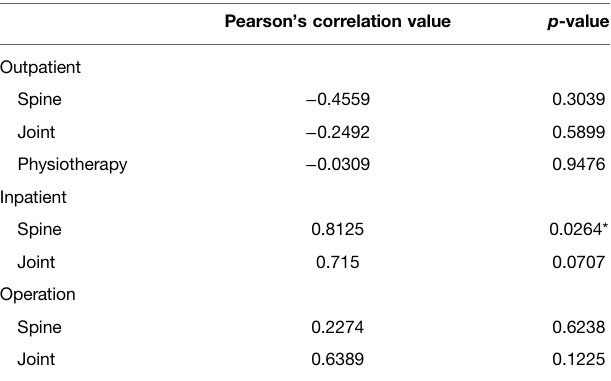
TABLE 4 | Linear relationship between the vaccination rate and visits to the orthopedic clinic. Pearson ’ s correlation value